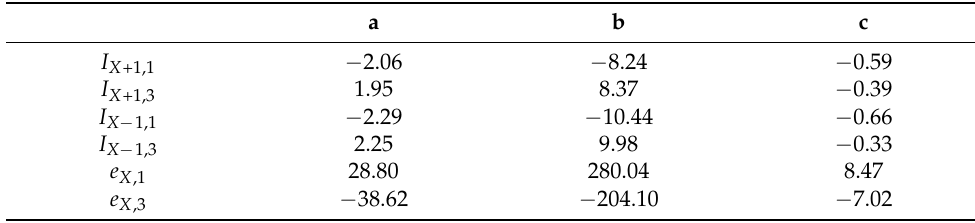
Table 1. Error coefficients for each